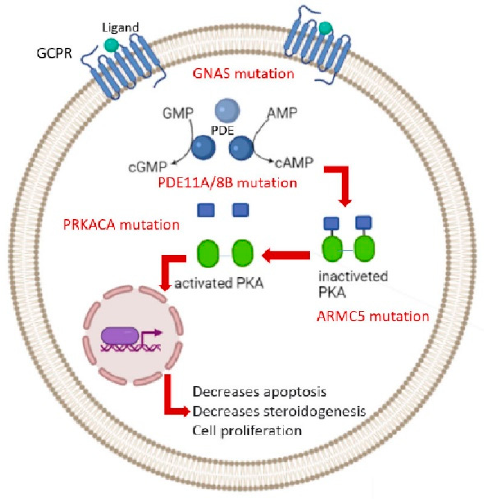
Figure 1. Genetics of Primary macronodular adrenal hyperplasia .